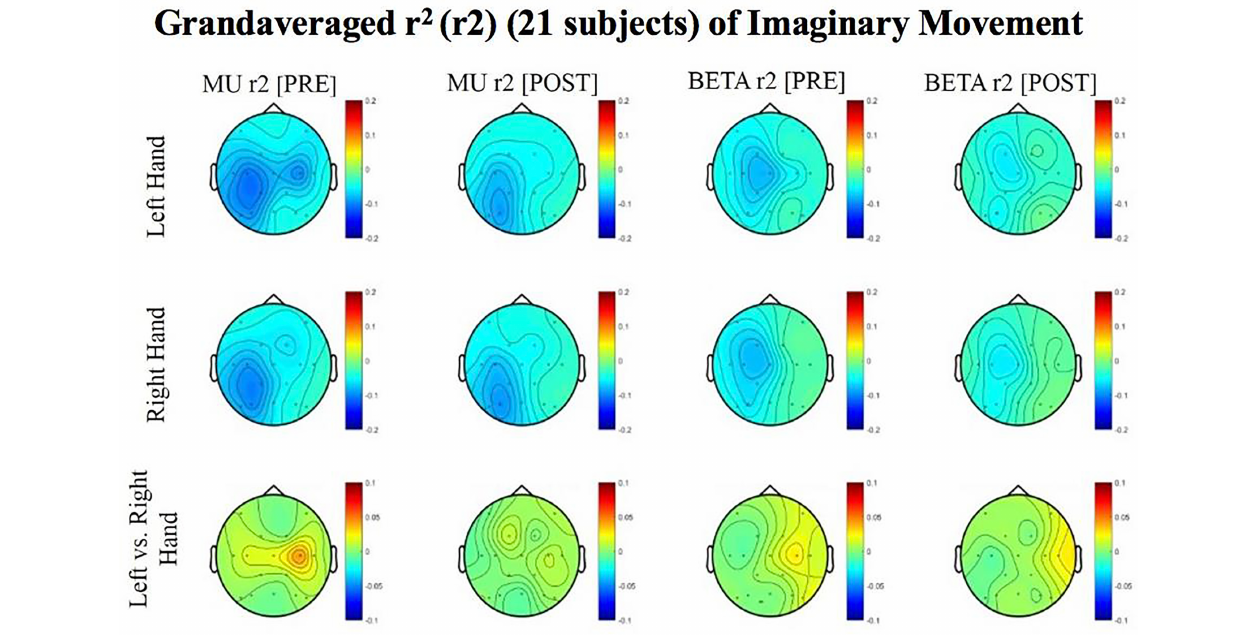
FIGURE 7 | Topoplots of grand averages for signed r-squared values at group level ( n = 21) for imaginary movements. Prescreening, open-looped training (PRE) and open-looped post screening BCI training (POST) runs (color bar: [0 = blue – 0.5 = red]). The majority of participants had a right lateralized lesion.